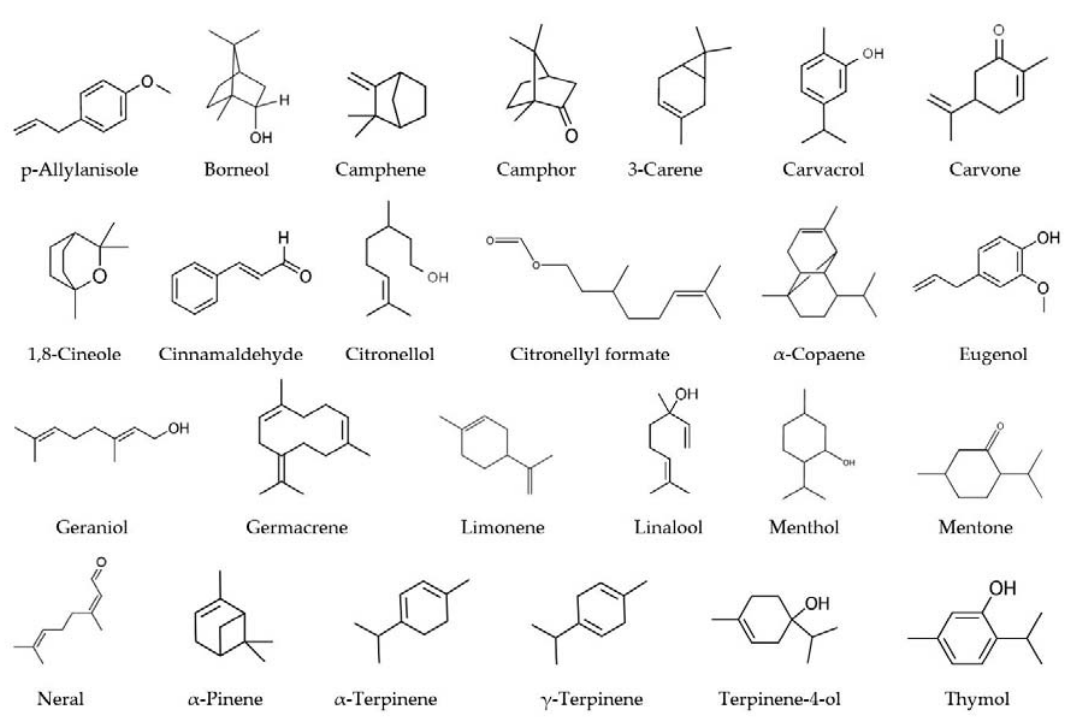
Figure 1. The chemical structures of major active compounds of essential oils (EOs) with antioxidant activity (in alphabetical order).